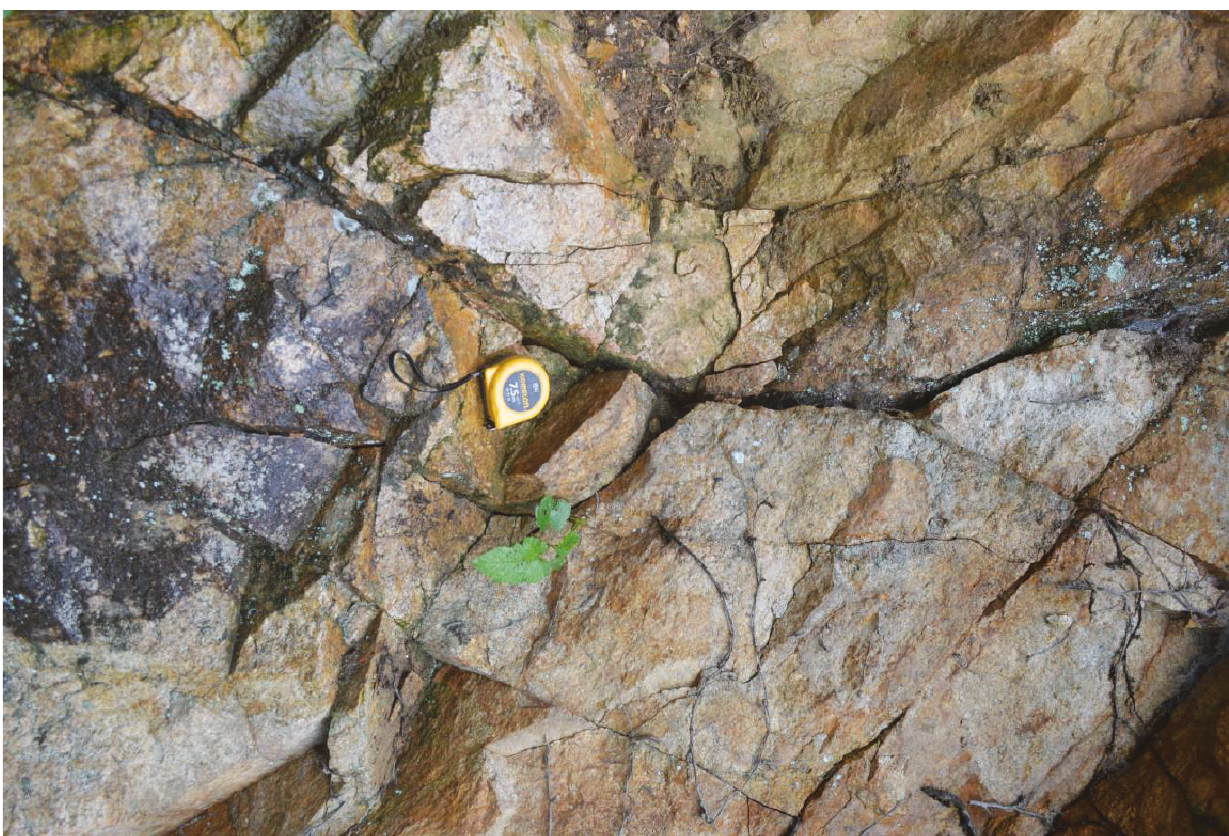
Figure 6: Outcrop of Yeongdeok granite near Jipum (36.4478351 ° N, 129.2705272 ° E; near the town of Yeongdeok, ~ 50 km north of Pohang; Figure 1), showing its highly fractured character. Tape measure (diameter ~ 8cm) provides scale. This granite is petrologically similar to the Pohang granite and part of the same Permian magmatic suite (e.g., [37]). Its highly fractured character can be considered indicative of the physical state of the Pohang granite. For the Yeongdeok granite, the typical spacing of fractures has been measured as ≤ 0.3m [98]. However, many of these fractures will have been formed during the last ~ 1 km of erosional unloading (cf. [99]); we thus adopt a nominal fracture spacing of 0.5m for our analysis of the Pohang